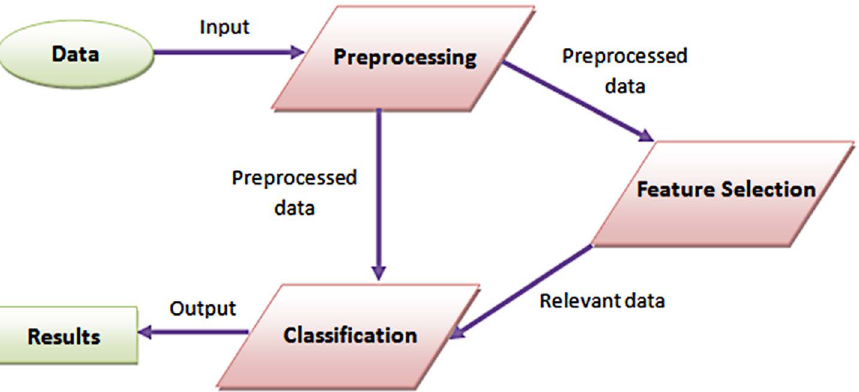
Figure 1. Overall System Architecture. The input data is preprocessed then the preprocessed data may be directly classified or feature selection is applied to utilize in the classification only relevant